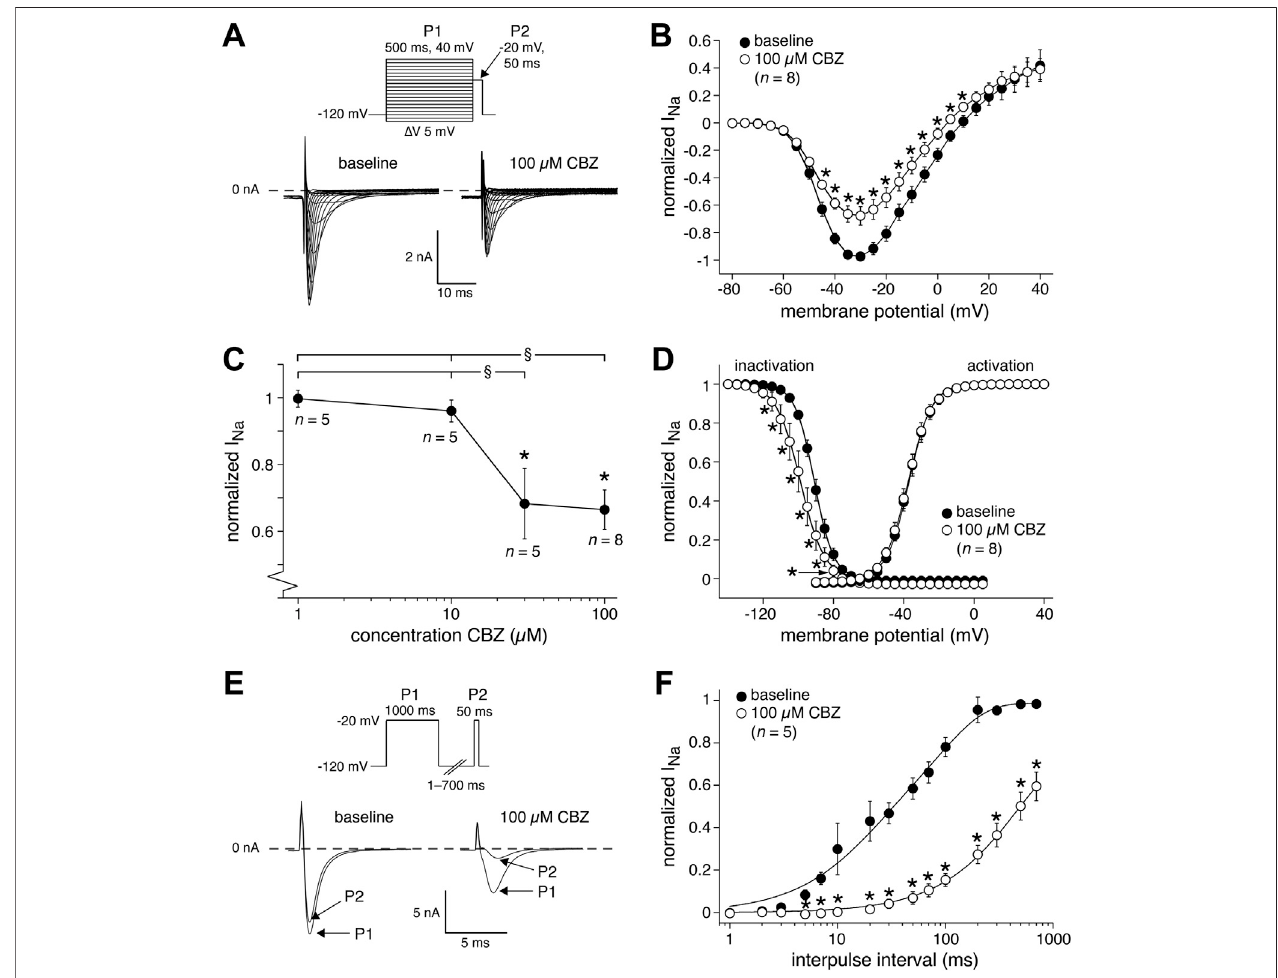
FIGURE 3 | Carbamazepine (CBZ) reduces the sodium current (I Na ) of rabbit ventricular cardiomyocytes in a use-dependent manner. (A) Typical I Na recordings between − 80 and 0 mV under baseline conditions and in presence of 100 µM CBZ. Inset: double-pulse voltage clamp protocol used to measure current-voltage (I – V) relationships (B) as well as the voltage dependency of (in)activation (D) . Cycle length was 5 s. (B) Average I-V relationship of I Na under baseline conditions and in presence of 100 µM CBZ. I Na was normalized to the maximal peak amplitude under baseline conditions, but peak current was set to − 1 to retain the well-known inward direction of I Na . * p < 0.05 CBZ versus baseline (Two-Way RM ANOVA). (C) Concentration dependency of the CBZ effects on I Na amplitude at − 35 mV * p < 0.05 CBZversusbaseline(One-WayRMANOVA); § p < 0.05higherversuslowerCBZconcentrations(One-WayANOVA). (D) Voltagedependencyof(in)activation. Solidlines are Boltzmann fi ts to the average data. * p < 0.05 CBZ versus baseline (Two-Way RM ANOVA). (E,F) Recovery from I Na inactivation measured with a double-pulse protocol(E,inset). (E) TypicalI Na recordingsunderbaselineconditionsandinpresenceof100 µMCBZwithaninterpulseintervalof100 ms. (F) Averagedata.Solidlines are double-exponential fi ts to the average data. * p < 0.05 CBZ versus baseline (Two-Way RM ANOVA).